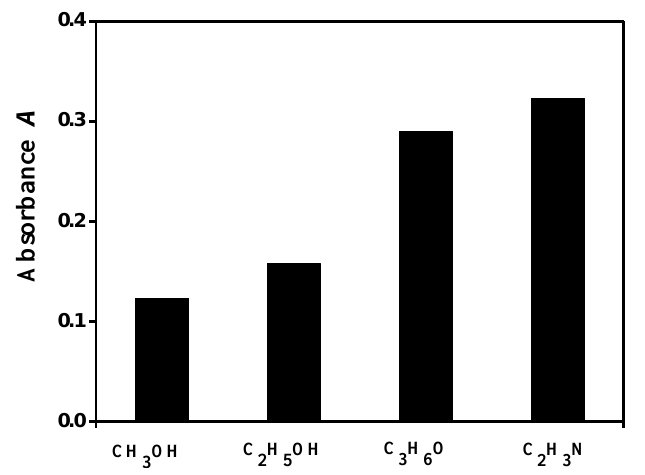
Figure 3. Effect of disperser solvent type on the extraction efficiency of Cu(II). Extraction conditions: 5.00 mL water sample, pH = 5.0, 100 µL 5 × 10 − 4 mol/L 5-Br-PADMA, 500 µL disperser solvent, 40 µL C 6 H 5 Cl, and 0.5 ng Cu.